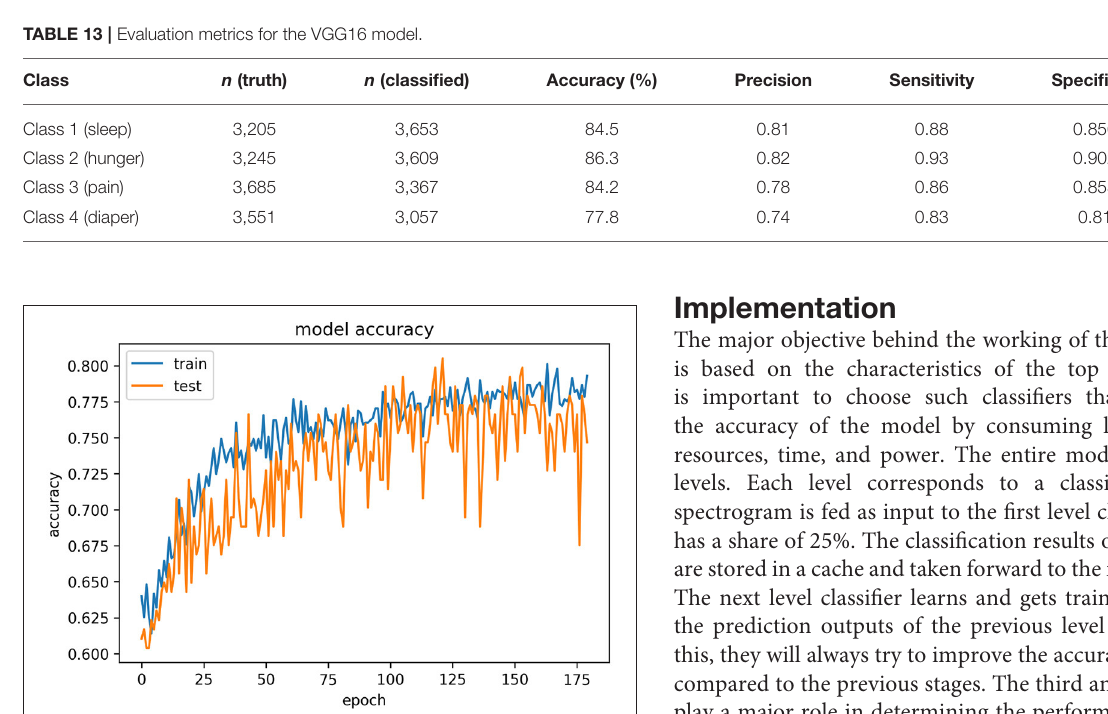
FIGURE 10 | Epochs vs. accuracy graph for the YOLOv4